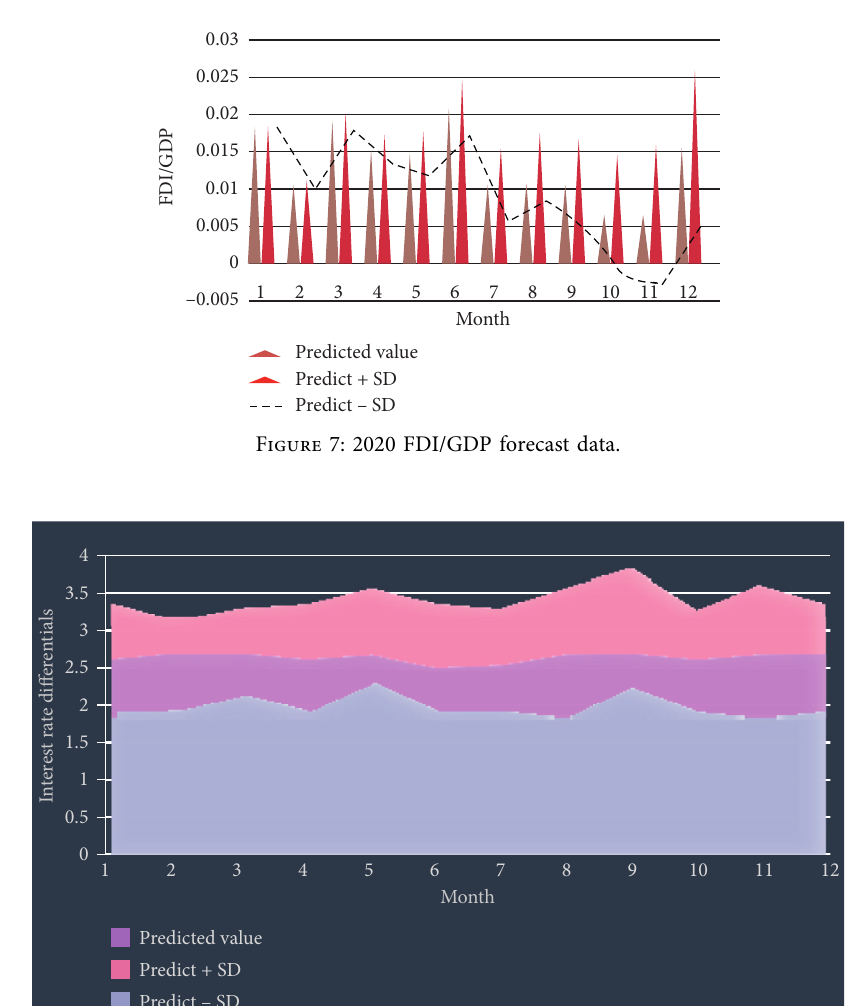
Figure 6: Dynamic Logit model estimation